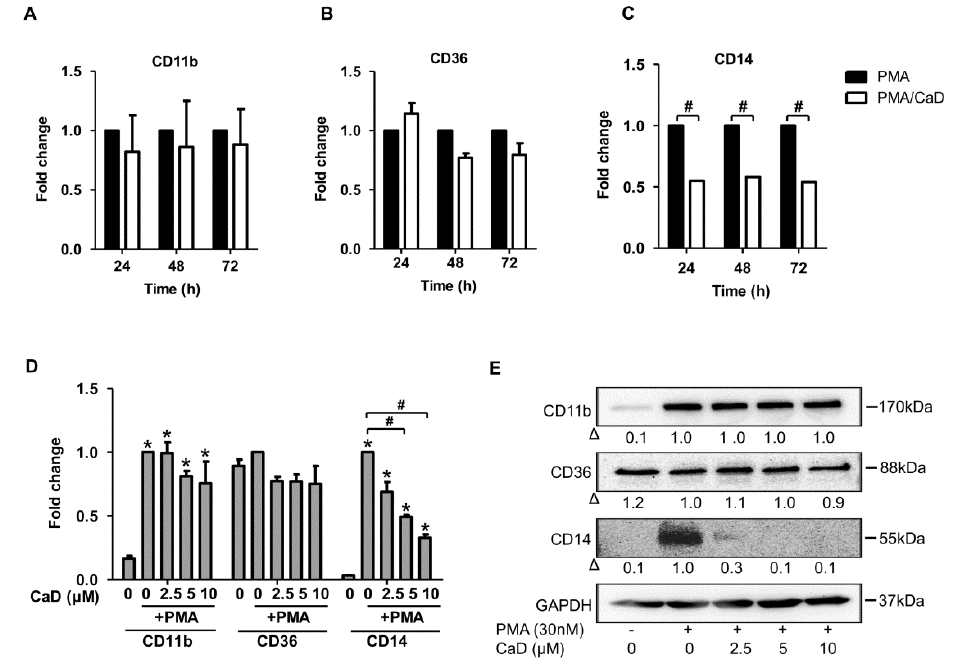
Figure 1. Calcium dobesilate (CaD) inhibits PMA-induced CD14 expression. THP-1 monocytes were pretreated with 10 µ mol/L CaD for 1 h, followed by stimulation with PMA (30 nmol/L) for various time points ( A – C ), or treated with various concentrations (0–10 µ mol/L) of CaD for 1 h ( D , E ) followed by PMA treatment for 72 h. Transcript levels of the indicated genes were measured by quantitative RT-PCR ( A – D ), and protein levels measured by Western blotting ( E ). ∆ , fold-change normalized to PMA only ( n = 3–4, mean ± SEM. * p < 0.05 vs. no treatment, # p < 0.05 vs. PMA only, Student’s t -test ( A – C ), or one-way ANOVA ( D )). The Western blot represents one from at least three independent experiments.